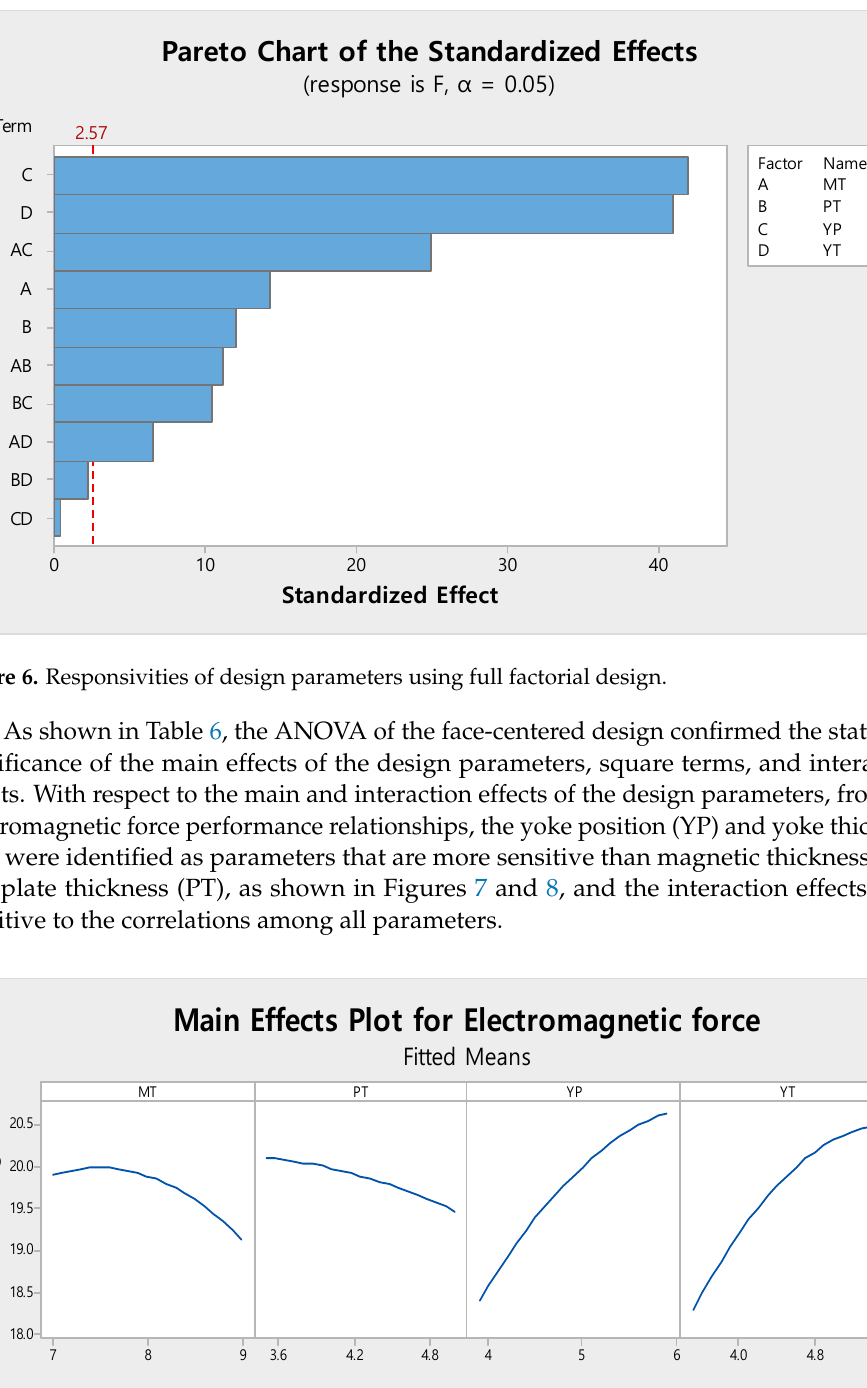
Figure 8. Interaction effects plot for electromagnetic force. The main effects were characterized by the negative correlations of MT and PT and the positive correlations of YT and YP with the electromagnetic force. The interaction effects were characterized by the positive correlations between the value of YP × YT and electromagnetic force, with the correlations of other parameters showing contradictory tendencies. The regression prediction model of the response value of the design parameters can derive the prediction equation from the results of the face ‐ centered design, which can be obtained with the quadratic regression model for the independent variable K as a quad ‐ ratic function of the face ‐ centered design, using Equation (3). Y (cid:3404) β (cid:2868) (cid:3397) (cid:3533) β (cid:2919) X (cid:2919)(cid:2921) (cid:2919)(cid:2880)(cid:2869)